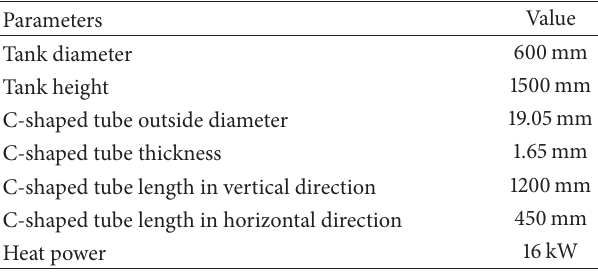
Table 1: Parameters of experimental